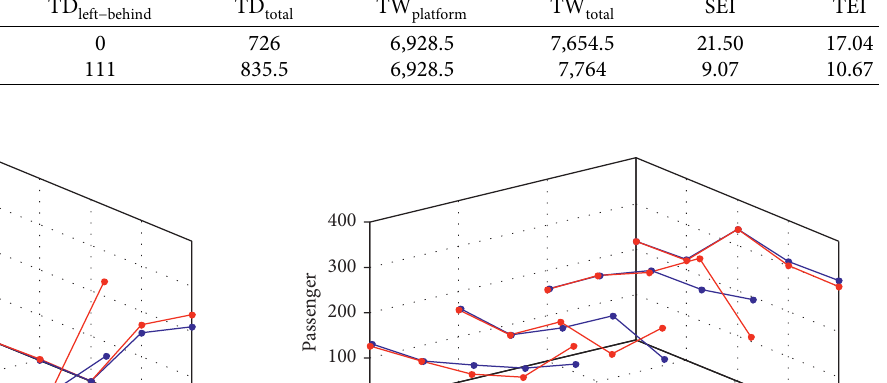
Table 11: Comparison of result for two forms of penalty functions (unit: minute). Model